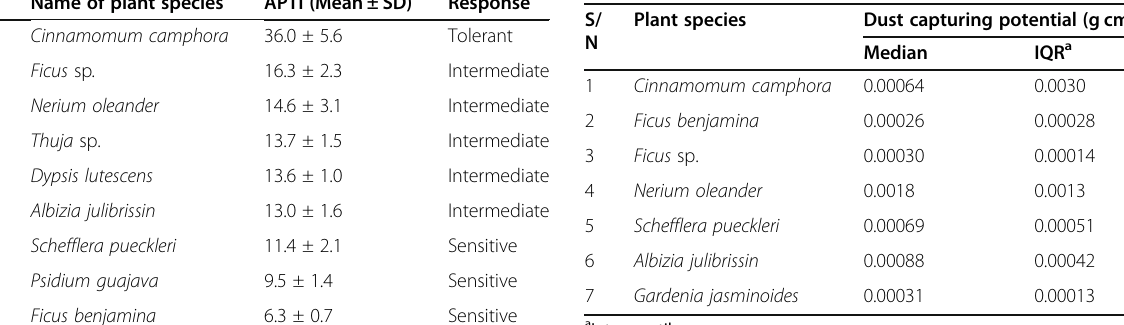
Table 3 Median ( n = 6) dust capturing potential of the studied plant